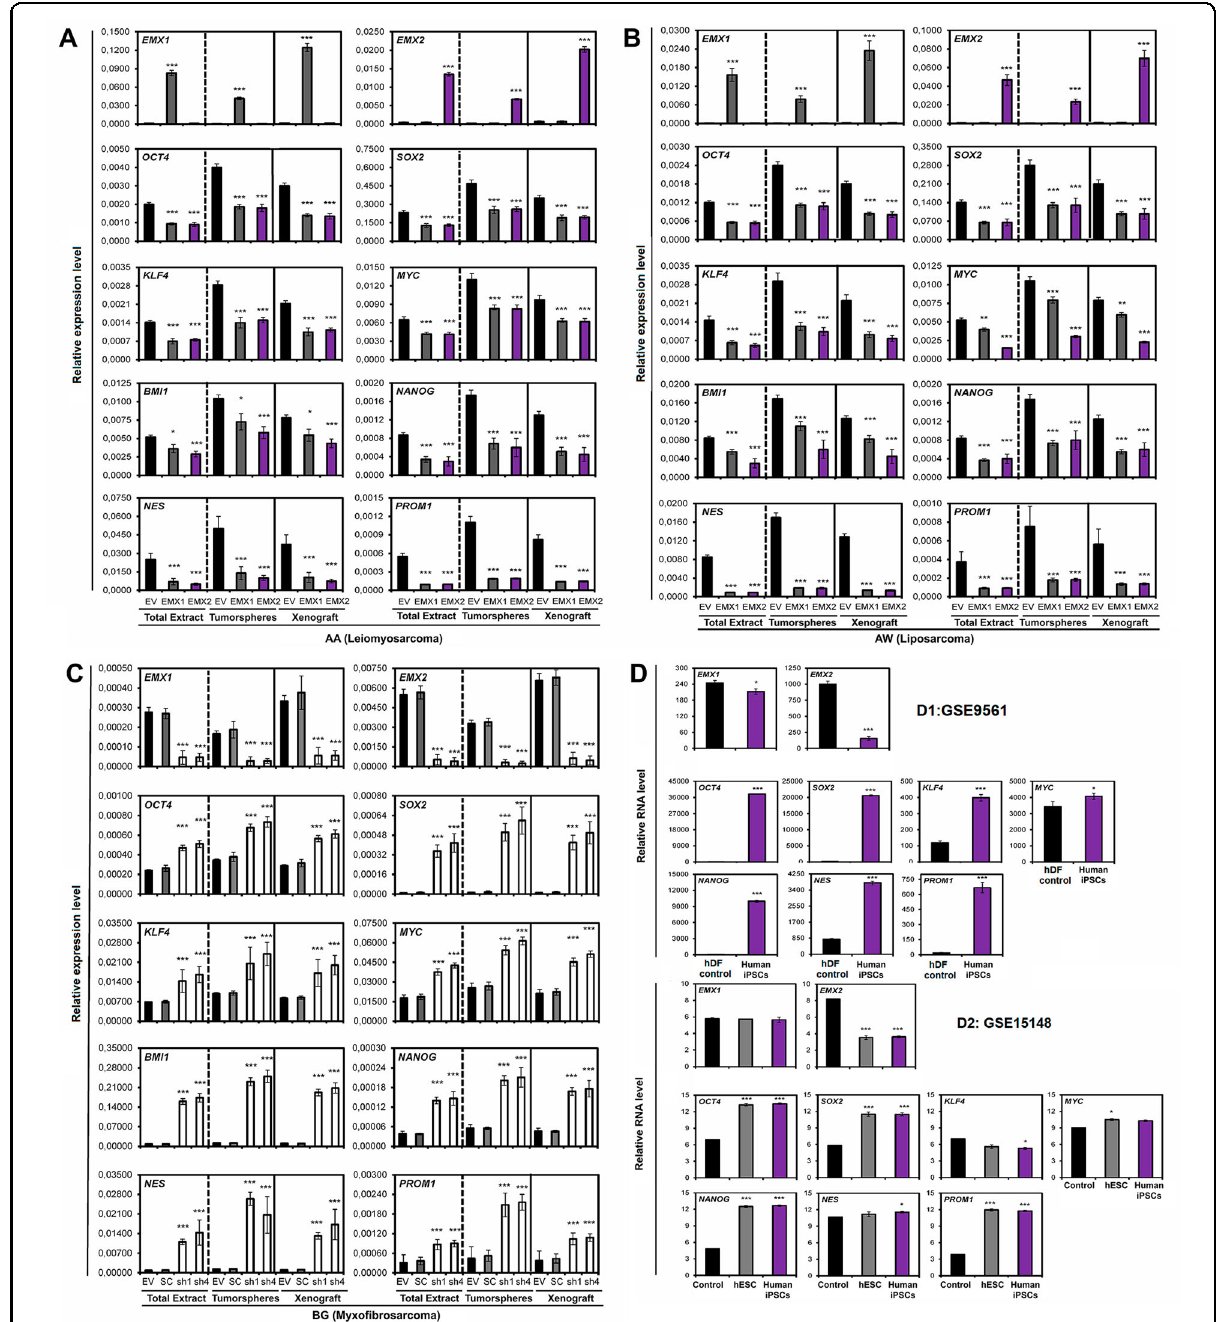
Fig. 4 Effect of EMX1 and EMX2 levels on the expression of genes related to the phenotype of stem cells. Quanti fi cation of the relative mRNA levels of the EMX1, EMX2, OCT4, SOX2, KLF4, MYC, BMI1, NANOG, NES, and PROM1 genes by qRT-PCR in the different cell lines with different levels of EMX proteins. The graphs show the expression levels (2 − Δ Ct ) of the different indicated genes for the total extract of the cell lines (ET), the tumorspheres (TO), and the xenograft tumors (XEN). A Line AA, B line AW, and C line BG. The average of a minimum of three independent experiments is represented in triplicate ± SD. Statistical analysis was performed with Student ’ s t -test (* p < 0.05; ** p < 0.01; *** p < 0.001). D Transcriptional analysis of the genes EMX1 and EMX2 , and those related to the properties of stem cells in public databases. D1 Analysis of the Yamanaka database (GSE9561), where the relative RNA levels of EMX1 and EMX2, and the genes related to the properties of stem cells (OCT4, SOX2, KLF4, and MYC) were measured. The database showed the transcriptome of induced pluripotent stem cells (iPSCs) generated from human dermal fi broblasts (hFDs). D2 Analysis of the Thomson database (GSE15148), where the relative RNA levels of EMX1 and EMX2, and stem cell genes were measured in human iPSCs generated from fi broblasts of the foreskin, used as a control and in human embryonic stem cells (hESCs). Statistical analysis was performed with Student ’ s t -test (* p < 0.05; ** p < 0.01; *** p <